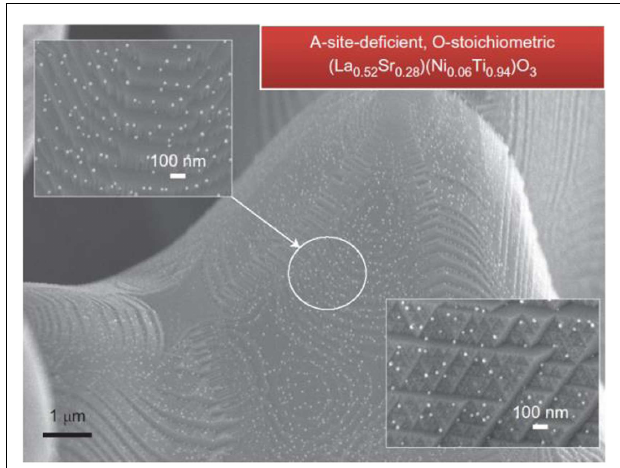
FIGURE 12 | Ex-solutions from the initiallyA-site-deficient, O-stoichiometric La 0.52 Sr 0.28 Ni 0.06 Ti 0.94 O 3 after reduction at 930°C (20h) in 5% H 2 /Ar (Neagu et al., 2013) . Reprinted with permission from Nature Publishing Group.